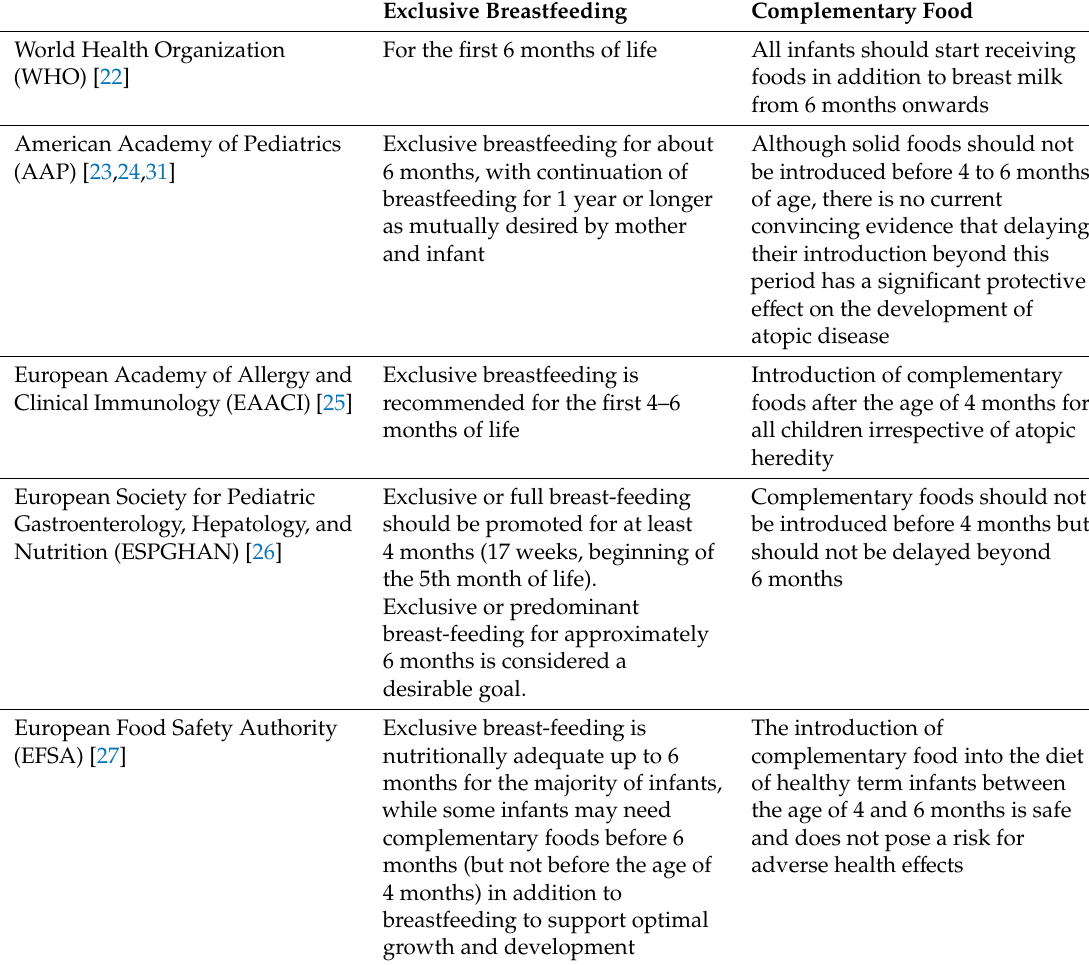
Table 1. Timing of exclusive breastfeeding and complementary food